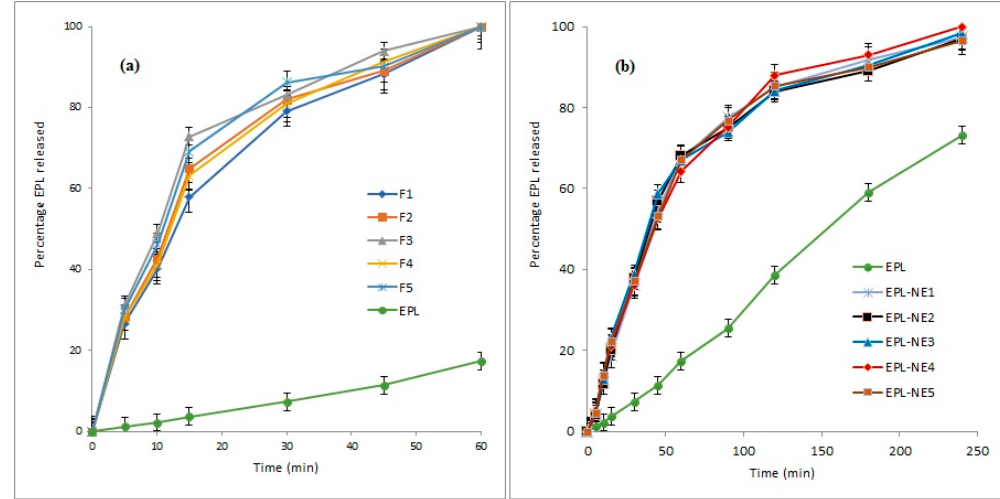
Figure 3. Release profiles of EPL from ( a ): NE-Liquisolids and ( b ): NE formulations in comparison to unformulated EPL.